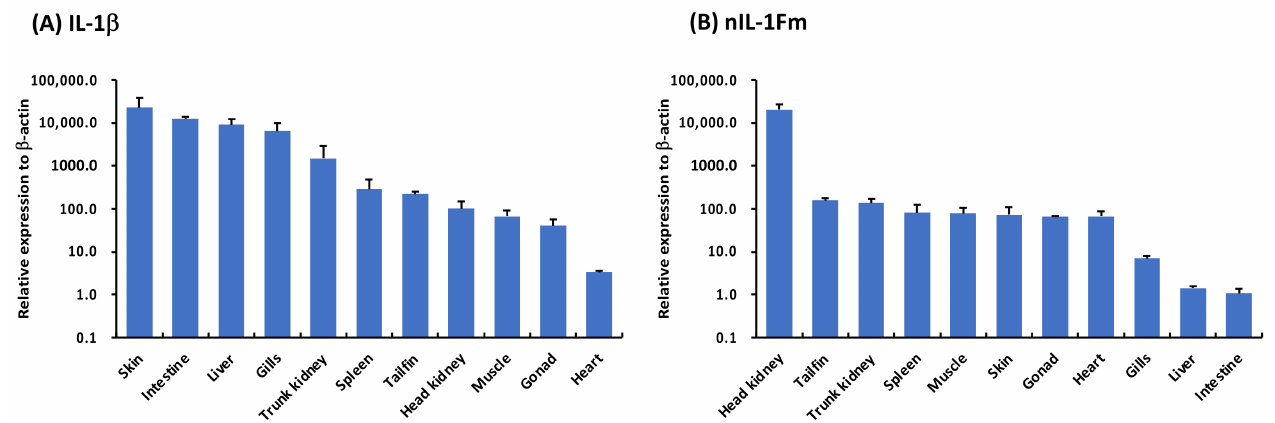
Figure 6. Tissue distribution of ( A ) IL-1 β and ( B ) nIL-1Fm transcripts in healthy Nile tilapia. qRT-PCR was used to determine the expression level of IL-1 β and nIL-1F in 11 organs from four fish. The relative expression level was normalized to the level of β -actin. The results are the mean + SEM of four